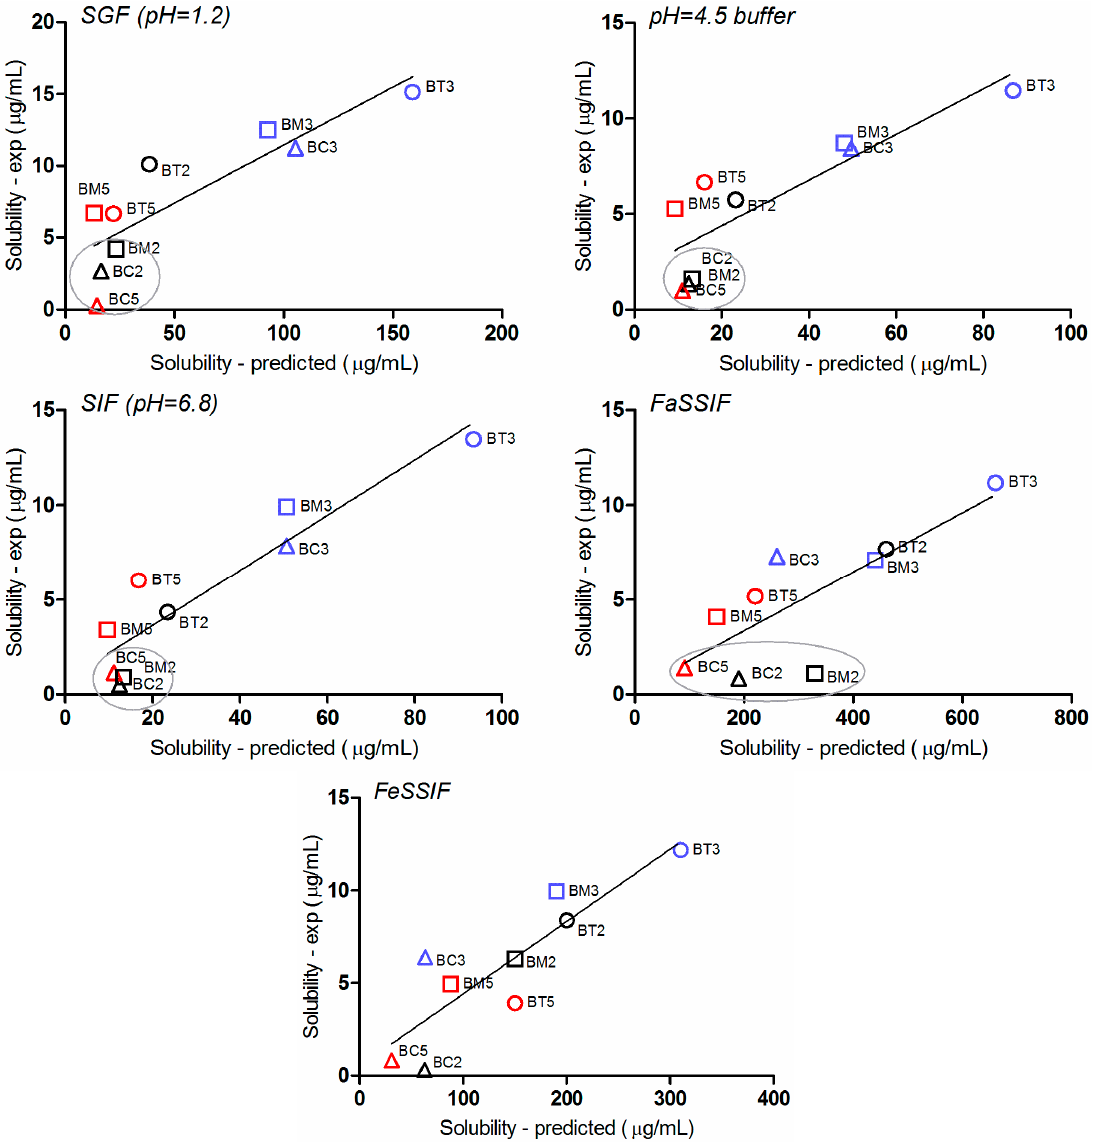
Figure 7. Correlation between the simulated and experimental solubility values in the five tested